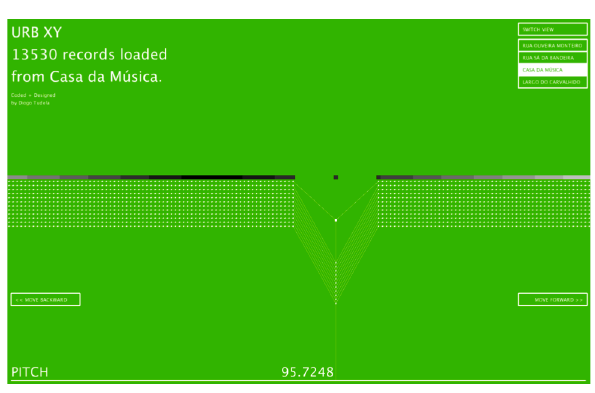
Figure 8 | Descriptor and data in URB XY